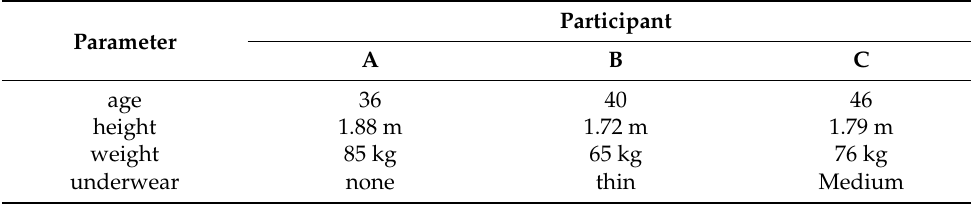
Table 1. Characteristics of participants.